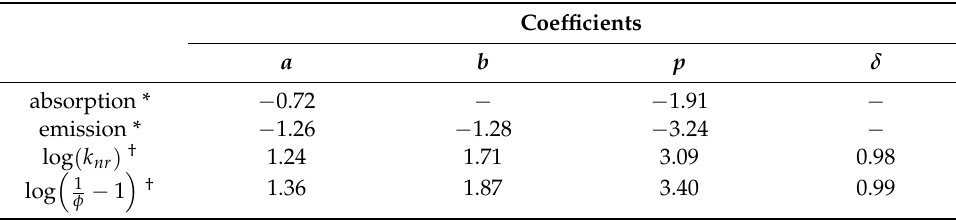
Table 2. Multivariable analysis of the solvatochromism and fluorogenicity of